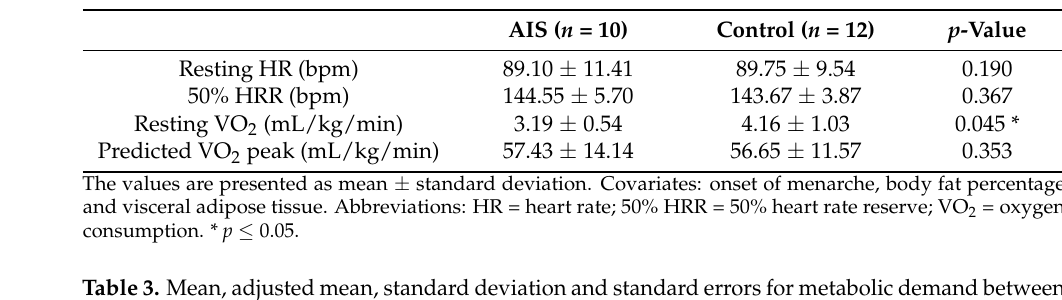
Table 2. Baseline metabolic demand parameters between AIS and control groups.